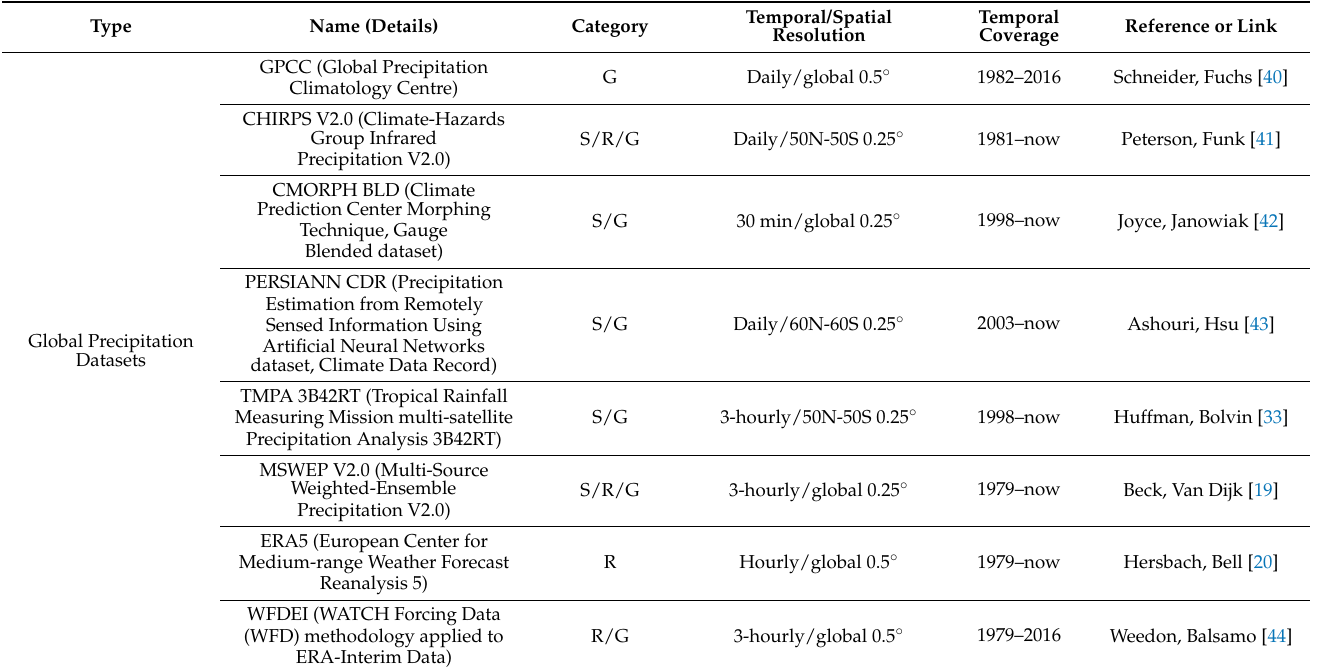
Table 1. Overview of the datasets used in this